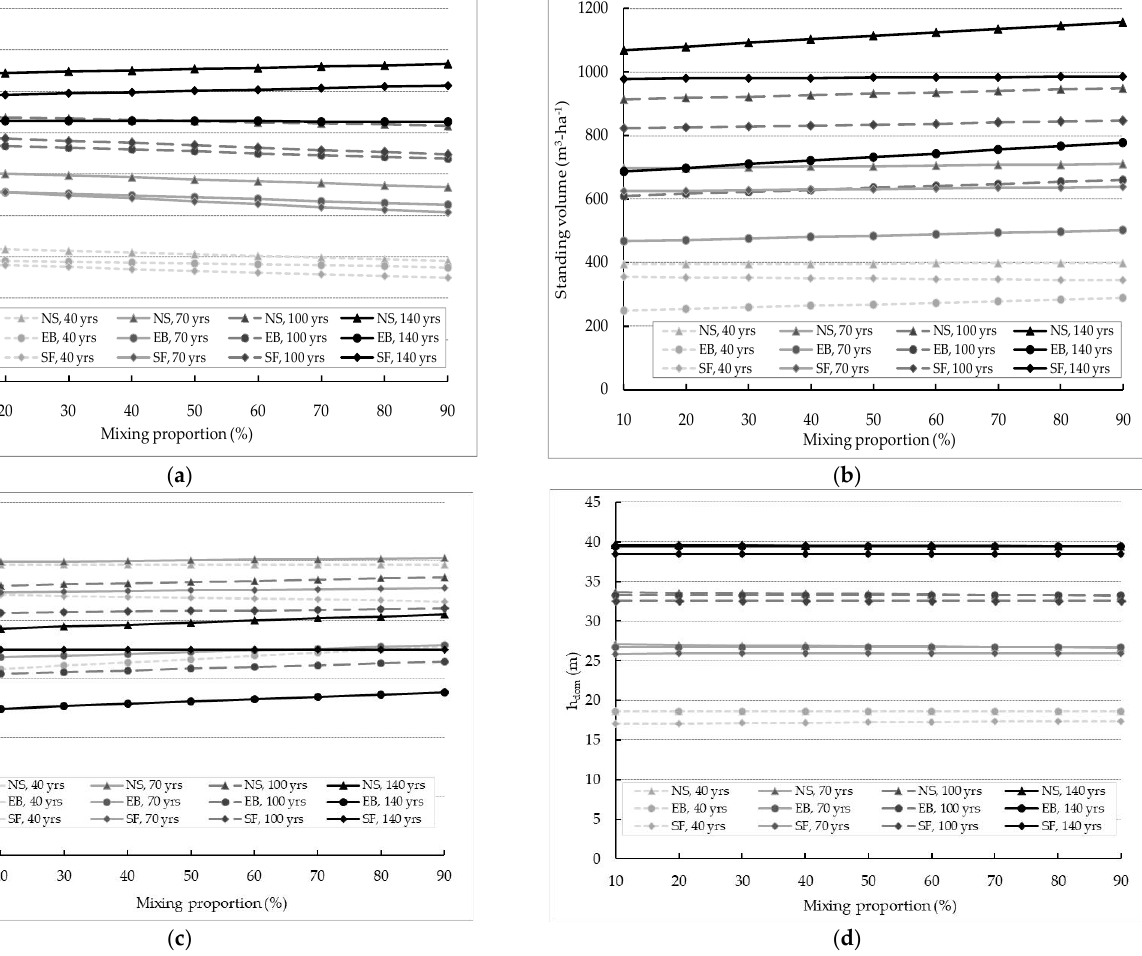
Figure 2. Spruce (NS), fir (SF), and beech (EB) in relation to their p sp in mixed stands: ( a ) h g variation; ( b ) V variation; ( c ) MAI variation; ( d ) h dom variation.